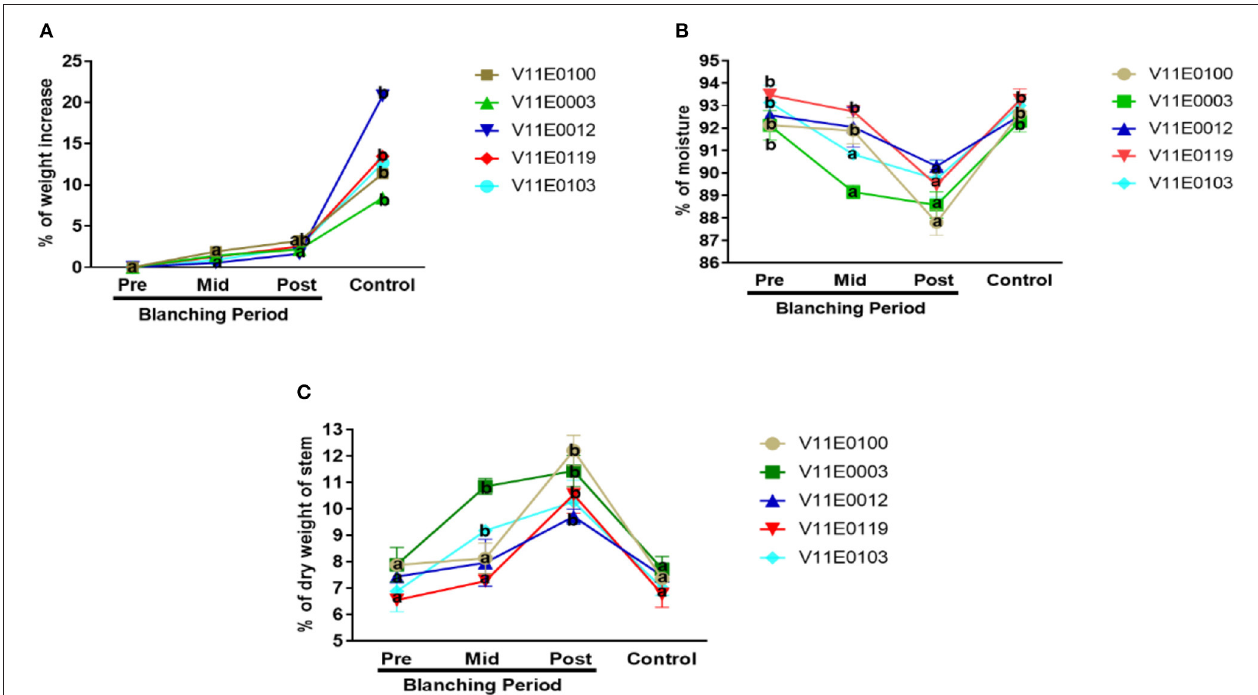
FIGURE 2 | Effect of blanching on the (A) fresh biomass, (B) moisture content, and (C) dry weight of the stem in five water dropwort cultivars. Four types of samples were used for analysis; Pre-blanching, Mid-blanching (20 days), Post-blanching (40 days), and Control (grown under normal conditions). Different letters indicate a significant difference ( P < 0.05) among the treatments according to the Tukey test. Values are means ± SE.